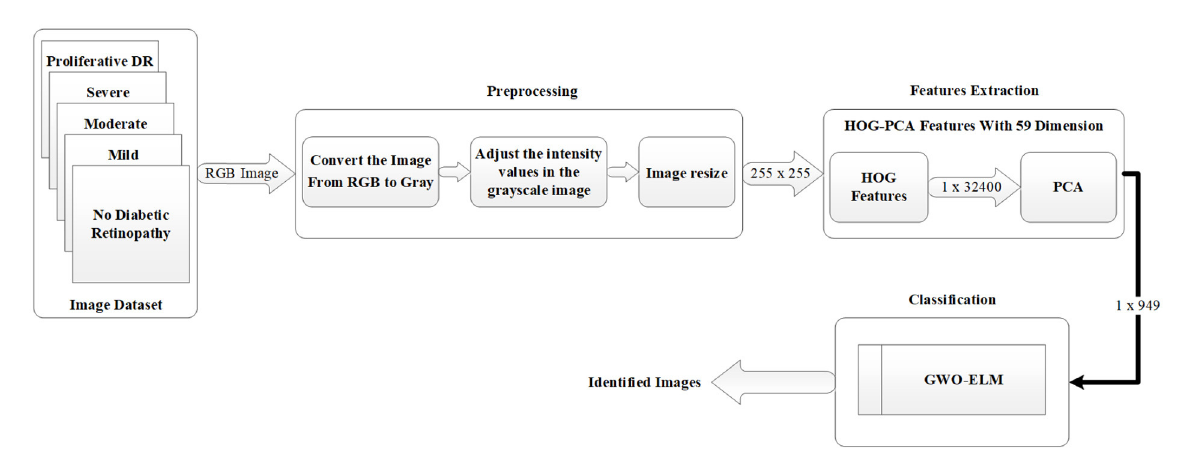
FIGURE1 Block diagram of the proposed DR detection